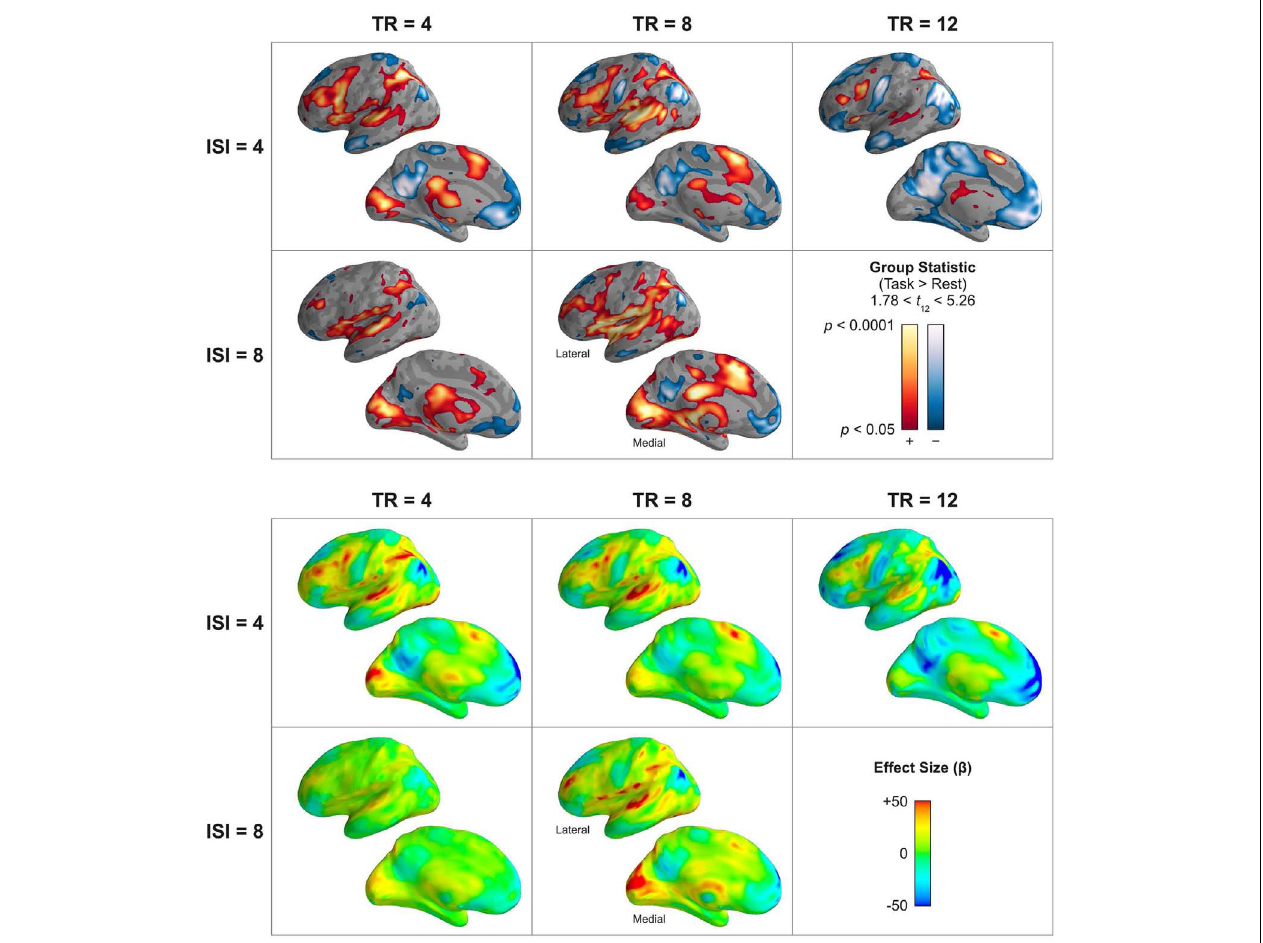
temporal cortex betweenTR = 4s andTR = 8s acquisition rates may indicate physiological saturation (reduced stimulus-evoked dynamic range of the BOLD signal) due to differences in the overall amount of acquisition-related scanner noise. However, both the estimated response magnitude and its statistical reliability tended to be dramatically reduced at very long acquisition rates (TR = 12s) compared to shorter rates (TR = 4s). Supplementary Figure 1 provides a volume-based depiction (axial slices) of these data. Supplementary Figure 5 illustrates these data for only clusters that survive correction for multiple